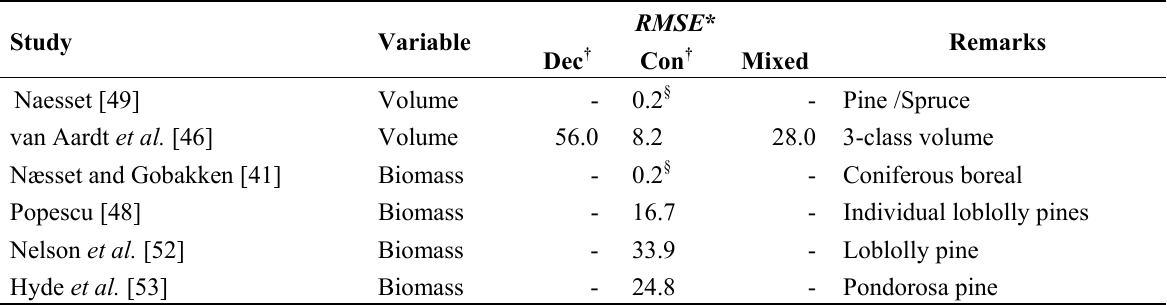
Table 1. Studies using small footprint lidar to estimate aboveground biomass/volume in